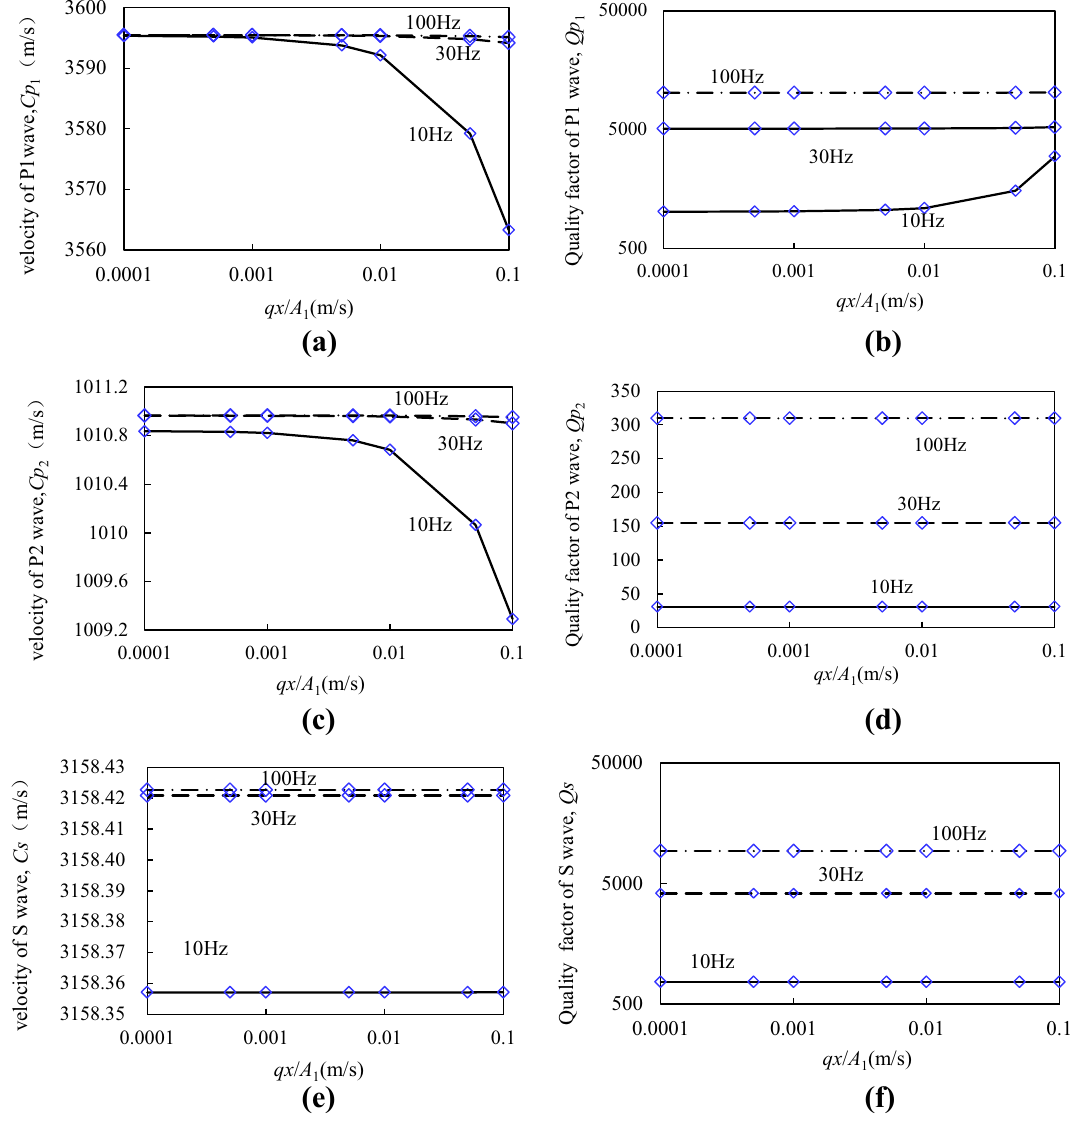
Fig. 2 Velocity and attenuation factor under different ratio of initial flow rate and solid scalar potential and vibration